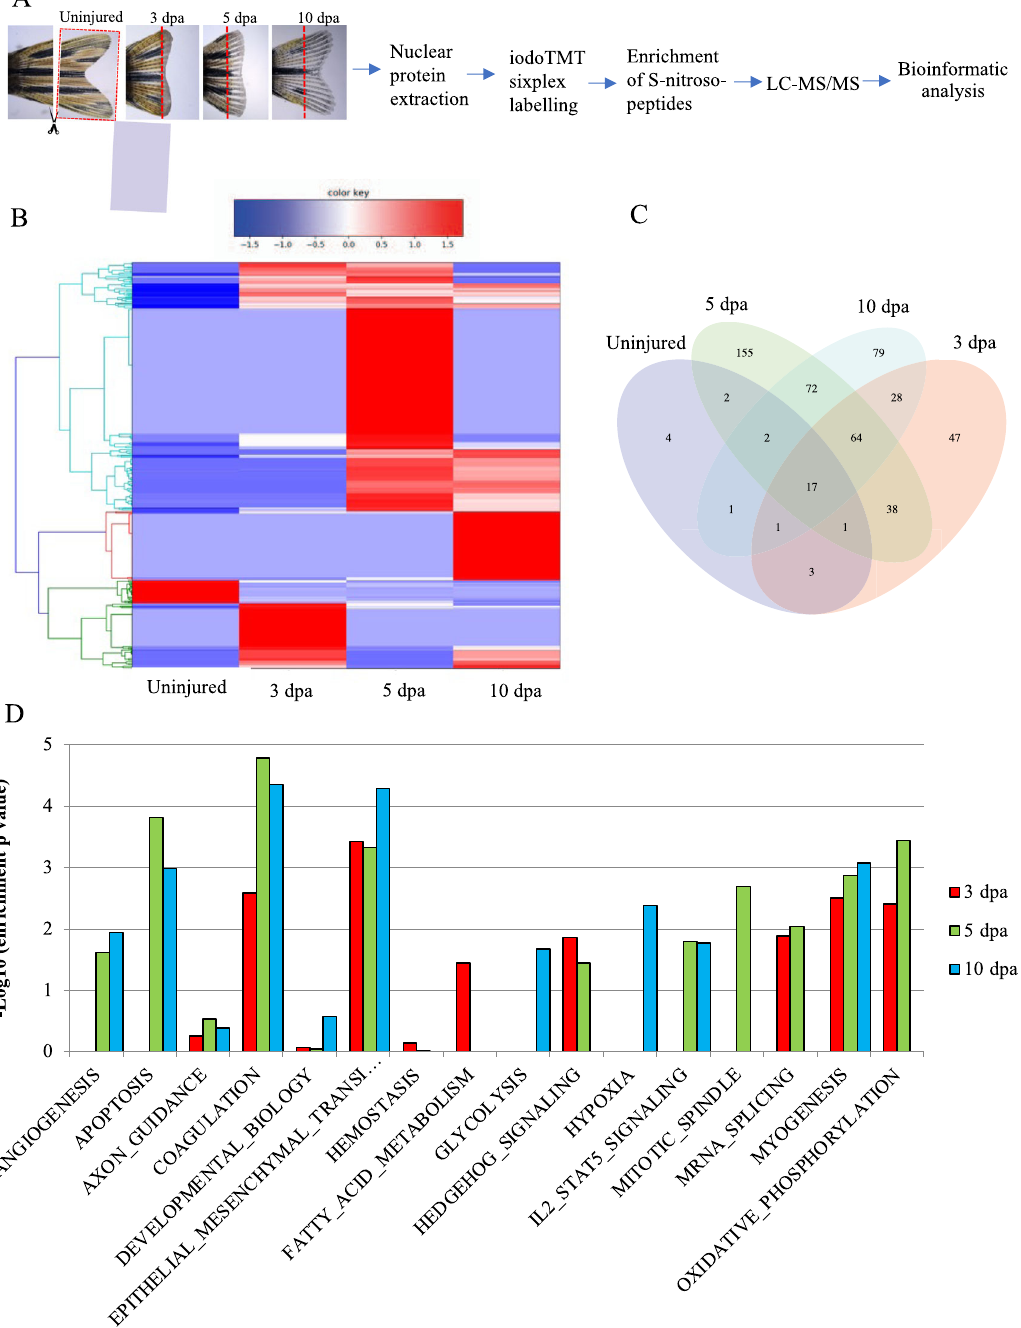
Fig. 2 Bioinformatic analysis of the S-nitrosylome in zebra fi sh tail fi n regeneration. A Work fl ow for the analysis of the S-nitrosylome. Tail fi ns of zebra fi sh (6 months old) were amputated; regrown tissue was collected in uninjured and at 3, 5, and 10 dpa (dash red lines represent the edge of the amputation); nuclear proteins were extracted and labeled with iodoTMT, digested with trypsin, and S-nitroso-peptides enriched through anti-TMT antibody containing resin and followed by LC-MS-MS. B , C Hierarchical clustering heat map and Venn diagram showing the dynamic changes in the number of S-nitrosylated nuclear proteins during the regeneration compared to uninjured. D Hallmark pathways enrichment by the differentially expressed S-nitrosylated proteins during regeneration compared to uninjured. The signi fi cant pathways are displayed along the x -axis. Dpa day post-amputation. N = 2 biological replicates, followed by bioinformatic Mass-spec revealed that Kdm1a, although detectable in the immunoprecipitated for Kdm1a (Fig. 3C). Zebra fi sh Kdm1a nucleus at all three time-points, becomes S-nitrosylated on protein has 85% identity with the corresponding human gene Cysteine 334 (Cys334) at 3 and 5 dpa (Fig. 3A, B). The increase of with the Cys334 corresponding to Cys360 in the human ortholog Kdm1a S-nitrosylation (S-NO) during tail fi n regeneration was (Supplementary Fig. S4A). Intriguingly, the sequence of 60 amino con fi rmed by western blotting for S-NO on samples previously acids (aa) from 50 upstream to 9 downstream of the Cys334